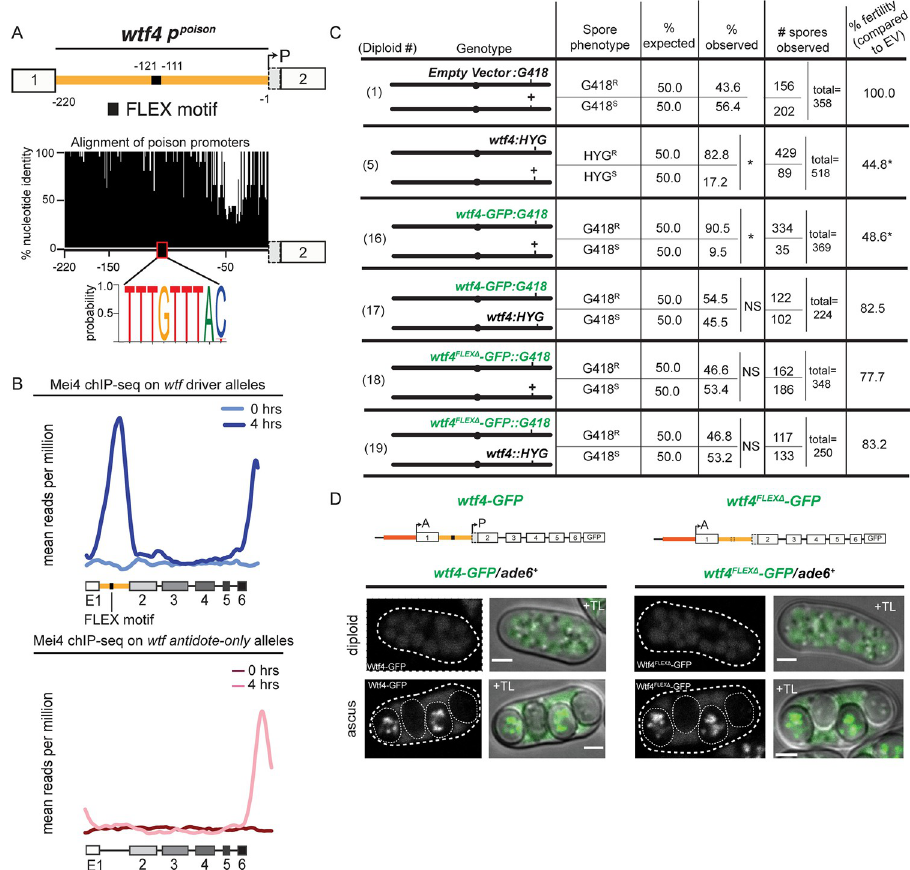
Fig 3. Master meiotic regulator, Mei4, controls Wtf4 poison transcription. ( A ) Depiction of the wtf4 poison promoter contained within intron 1. There is a FLEX motif (black box, TGTTTAC in opposite orientation) located 111 to 117 nucleotides upstream of the Wtf4 poison transcriptional start site. Percent consensus nucleotide identity of intron 1 sequences of 28 predicted poison-antidote wtf drivers [36] from three different strains of S . pombe (the reference genome, S . kambucha , and FY29033 ). The figure shows the percent consensus identity at each nucleotide position, excluding gaps. ( B ) Mei4 Chip-seq data (data from [50]) showing Mei4 binding on wtf genes at both 0 hours and 4 hours after meiotic induction. On the top panel, the reads are aligned to the predicted wtf meiotic drive genes ( wtf4 , wtf13 ) and on the bottom the reads are aligned to the wtf genes that are predicted to only encode antidote proteins ( wtf5 , wtf9 , wtf10 , wtf16 , wtf18 , wtf20 , wtf21 , wtf25 ) in the S . pombe genome version ASM294v2. For any reads that mapped to more than one location, only a single location, chosen at random, is reported. ( C ) Allele transmission and fertility (assayed via viable spore yield, VSY) of diploids with the depicted genotype. Alleles listed are at ade6 . The genotype column shows a cartoon depiction of the relevant genotype. The progeny phenotypes are then shown on the right. For diploids heterozygous at one locus (e.g., Diploid 1), two values are shown (top and bottom) that represent the two possible haploid genotypes. Spores exhibiting both parental phenotypes were considered diploid or aneuploid and were excluded from this table but can be found in S1 Data. The expected values assume Mendelian allele transmission. ( � = p < 0.05, NS = not significant; G-test for allele transmission, Wilcoxon test for VSY, in comparison to the empty vector control). We compared all diploids to diploid 1 as the control. The data for diploid 1 is also depicted in S2A and S9A Figs. Diploid 5 is also shown S2A Fig. ( D ) Images of heterozygous wtf4-GFP/ade6+ (left) and wtf4 FLEX Δ -GFP/ade6+ (right) diploids and asci acquired after 1 day on sporulation media. Wtf4-GFP and Wtf4 FLEX Δ -GFP are shown in green. Scale bar represents 2 μ M. TL = transmitted light. All images are shown at the same brightness and contrast for accurate